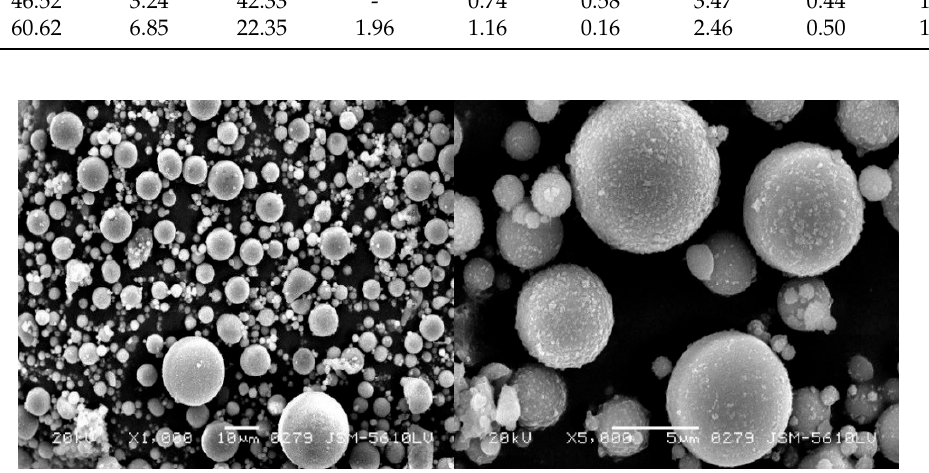
Figure 1. Scanning electron micrograph of coal fly ash.